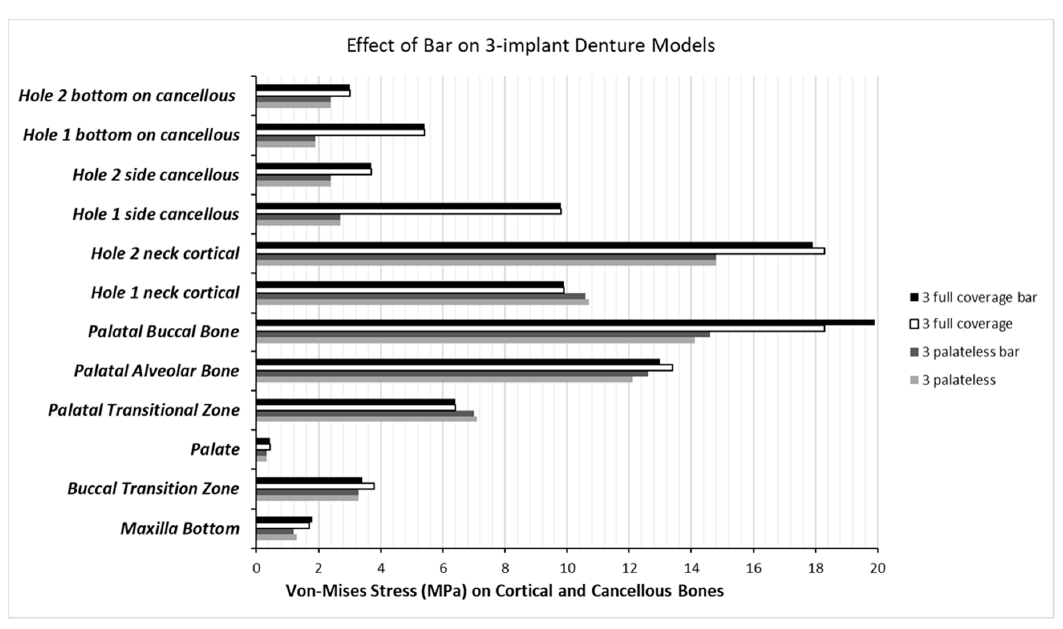
Figure 6. Effect of Bar on three-implant overdenture models with axial loading. Figure 6. E ff ect of Bar on three-implant overdenture models with axial loading. Appl. Sci. 2020 , 10 , x FOR PEER REVIEW